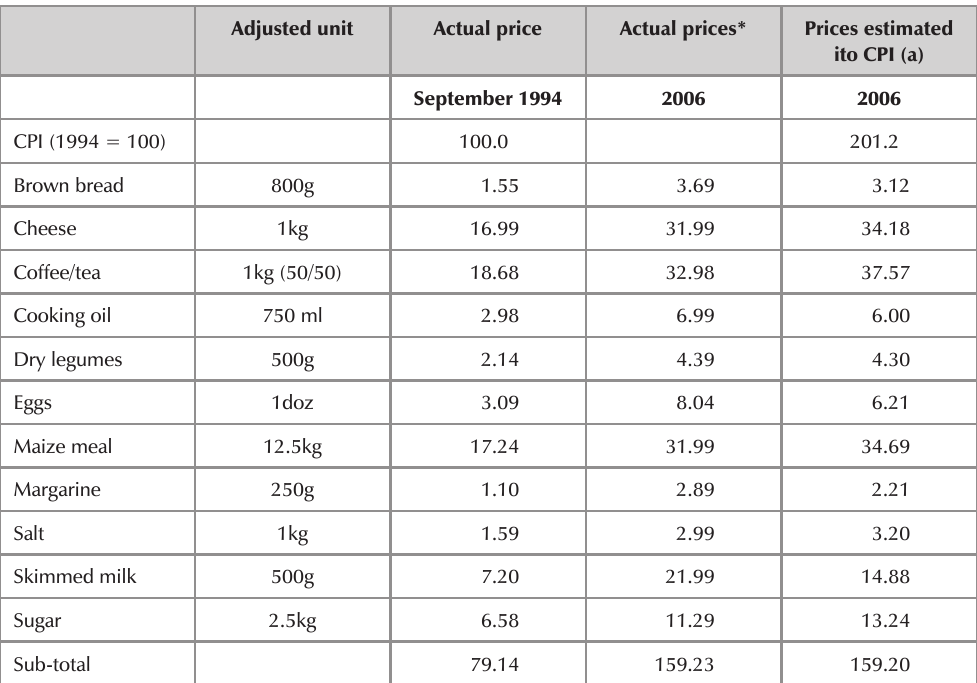
Comparison of actual and estimated prices of selected goods, 1994 to 2006 (all prices in R) Table 3a Average prices of food